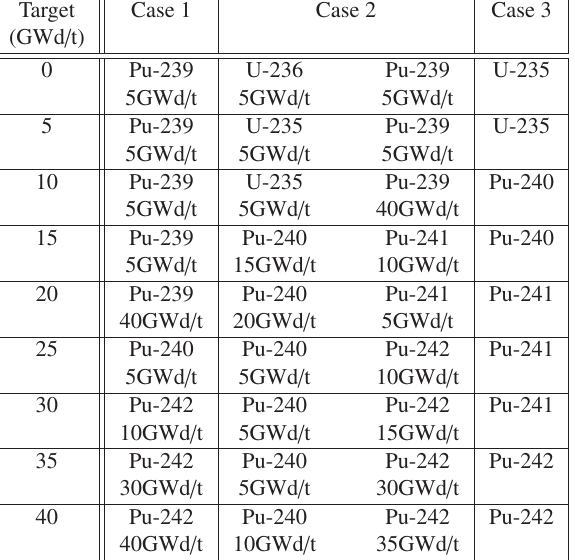
Table 1. Mockup parameters and their combinations with which the maximum RFs are obtained